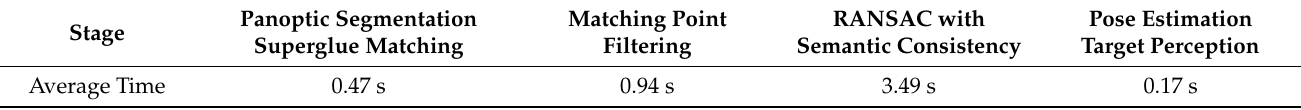
Table 2. Results of test